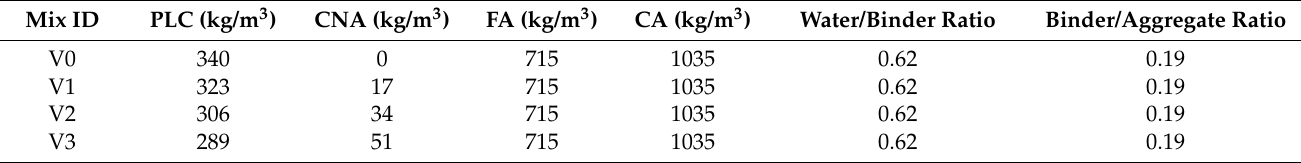
Figure 2. The PSD of aggregates used. CA is coarse aggregate, FA is fine aggregate, and LL and UL are lower and upper limits.